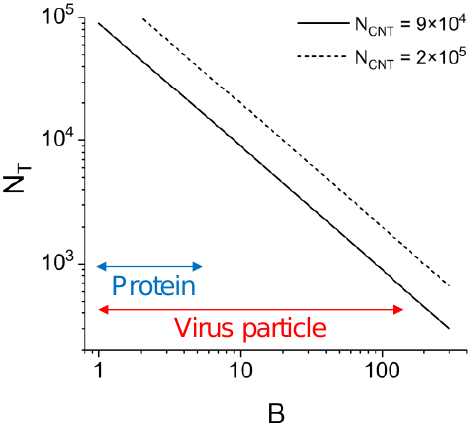
Figure 6. Detectable number of target analyte ( N T ) against the number of CNT labels bound to one target analyte ( B ) for the detectable number of CNTs ( N CNT ) of 9 × 10 4 and 2 × 10 5 tubes. Blue and red arrows indicates typical ranges of B for proteins and virus particles.